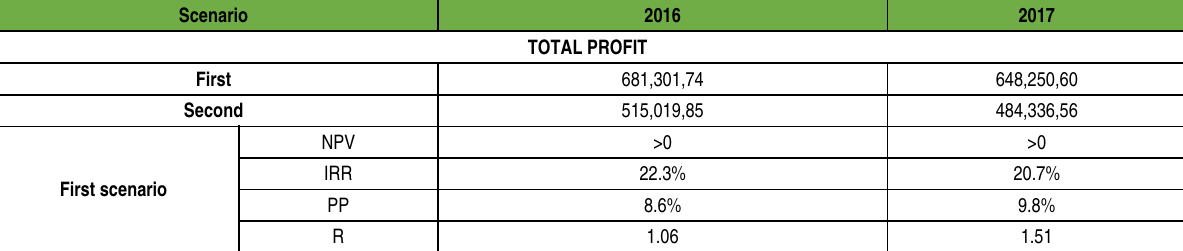
Table 10. The findings: estimated profit and loss of opportunities, EUR